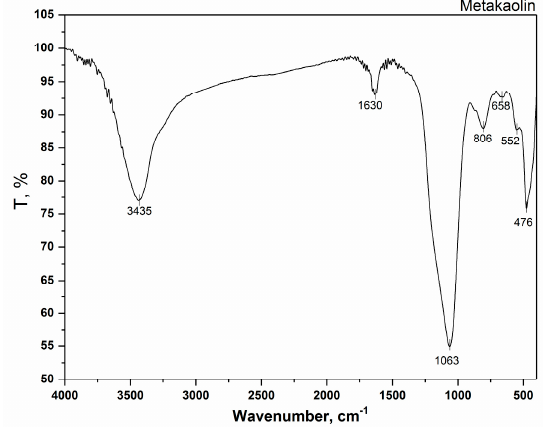
Figure 4. Fourier transform infrared (FTIR) spectrum of the metakaolin.